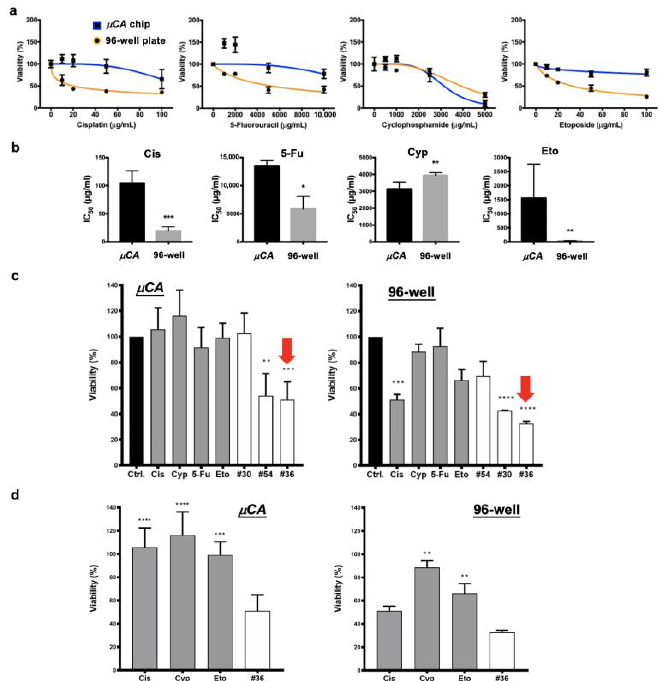
Figure 4. Comparisons of drug testing derived from the µCA chip and the conventional 96-well plate: ( a ) Drug profiles of 24 h cisplatin (Cis), 5-fluorouracil (5-Fu), cyclophosphamide (Cyp), and etoposide (Eto) acting on MCF-7 cells, which are derived from µCA chips and 96-well plates, re- spectively. The lowest drug concentration used for each screening was 0 µg/mL. ( b ) Comparison of the drug IC 50 values derived from µCA chip and 96-well plate results (Figure 4a). ( c ) Comparison of cell viabilities obtained from the optimal drug combinations and the corresponding single-drug treatments. The single-drug concentrations were 15 µg/mL (49.8 μM), 400 μg /mL (1532 μM), 3000 µg/mL (23, 280 μM) , and 10 µg/mL (17 μM) for Cis, C yp, 5-Fu, and Eto, respectively. All data were compared to the control. The optima were selected from #30, #36, and #54 groups; please refer Sup- plementary Figures S2 and S3 for more detail. The red arrows represent the optimized drug combi- nations. ( d ) Comparisons of cell viabilities obtained from the optimized #36 combination and the corresponding single-drug treatments. Data represent the mean ±SD, n = 3 independent experi- ments. * p < 0.05, ** p < 0.01, *** p < 0.001, and **** p < 0.0001. 3.3. Successful Translation of the Selected Optimal Drug Combination into Zebrafish Tumor Xenograft Model To leverage the efficiency of comparing in vitro and in vivo assays, zebrafish tumor xenograft models were used for comparison (Figure 5a). Engrafted MCF-7 tumors with DiI labeling were easily detected by fluorescence microscopy and exactly matched the lo- cation of tumors observed in bright-field images. The results show that the screened opti- mal drug combination #36 from the µCA chip presented significant tumor inhibition, as compared with the control (Figure 5b). Nonetheless, no significant difference was ob- served among the single drugs administrated, except that the drug Eto likely improved the tumor growth. In addition, drug combination #54 attenuated the in vivo tumor growth, although the inhibition rate was not significantly different from that of the con- trol. Instead, there was no significant attenuation of tumor growth when drug combina- tion #30 was adopted. The detailed characteristics of the three assays are presented in Ta- ble 1.